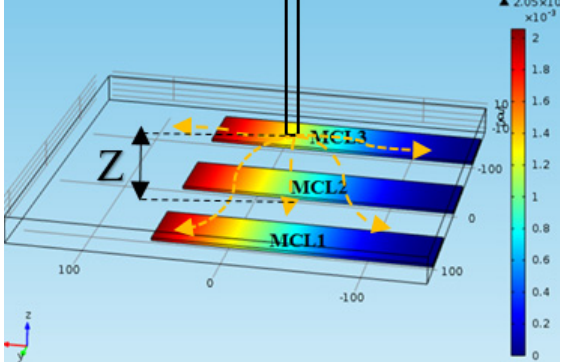
Figure 9. The MCL1, MCL2, and MCL3 that were used for the analysis of Z distance (vertical distance). A microneedle is focused on three microcantilever, and the deflections are derived based on the number of forces exerted on top of MCLs. Then according to the electrical output of sensors, the testing will be processed. The microneedle could be moved across the surface of the chip and blow air on every component of interest.